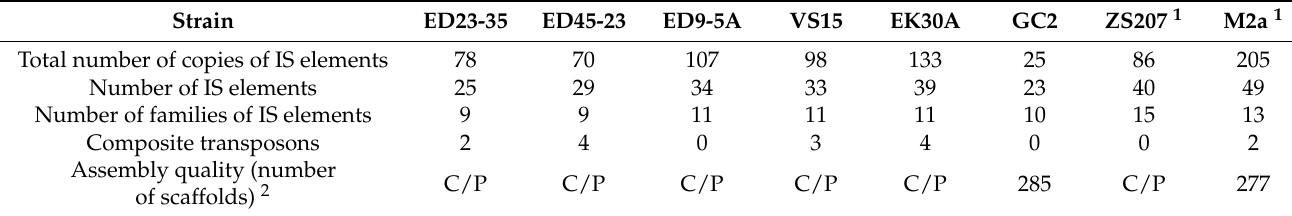
Table 6. Mobile elements in environmental strains of A. lwoffii .